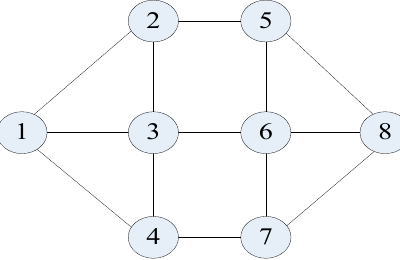
Figure 5. Example of a middle-sized SN on AON BN.